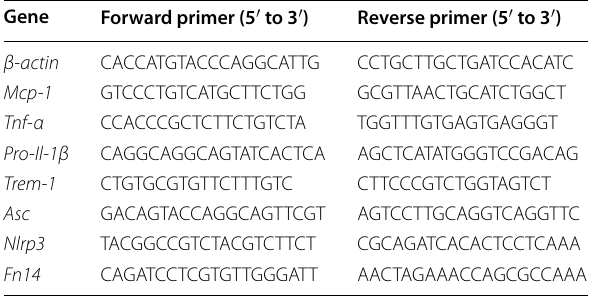
Table 1 Sequences of specific primers used in this study Gene Forward primer (5 ′ to 3 ′ )